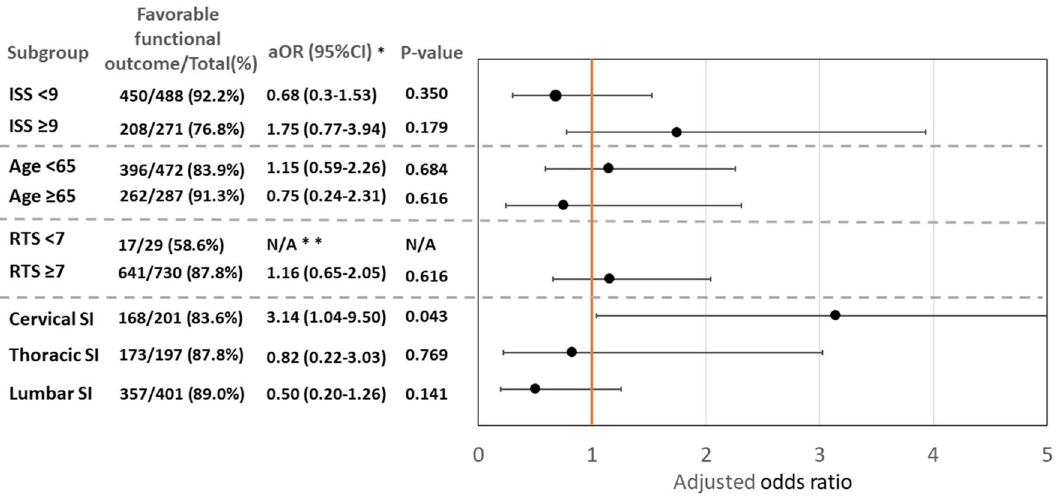
Figure 2. Subgroup analysis for favorable neurologic outcome, ISS < 9, ISS ≥ 9, age ≥ 65, age < 65, adjusted multivariable logistic regression. aOR adjusted odds ratio, SI spinal injury. *All subgroups except RTS < 7 were adjusted by country, age, sex, scene-to-hospital time, mechanism, prehospital fluid management, cervical spinal injury, thoracic spinal injury, lumbar spinal injury, torso injury, revised trauma score, ISS, received spine operation, and received other operations. **Due to the small subgroup size, multivariable logistic regression was not